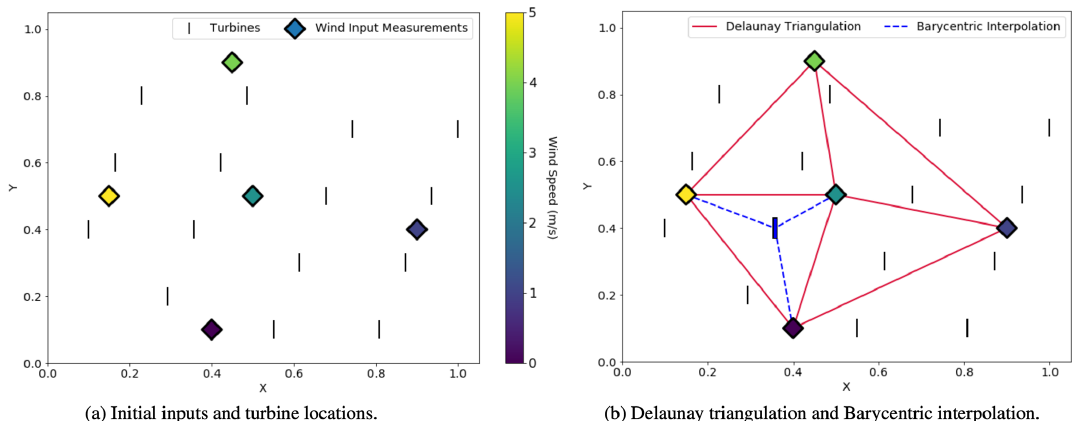
Figure 2. A visual depiction of the methods used to interpolate and define atmospheric characterization values at specific points within the input coordinates.